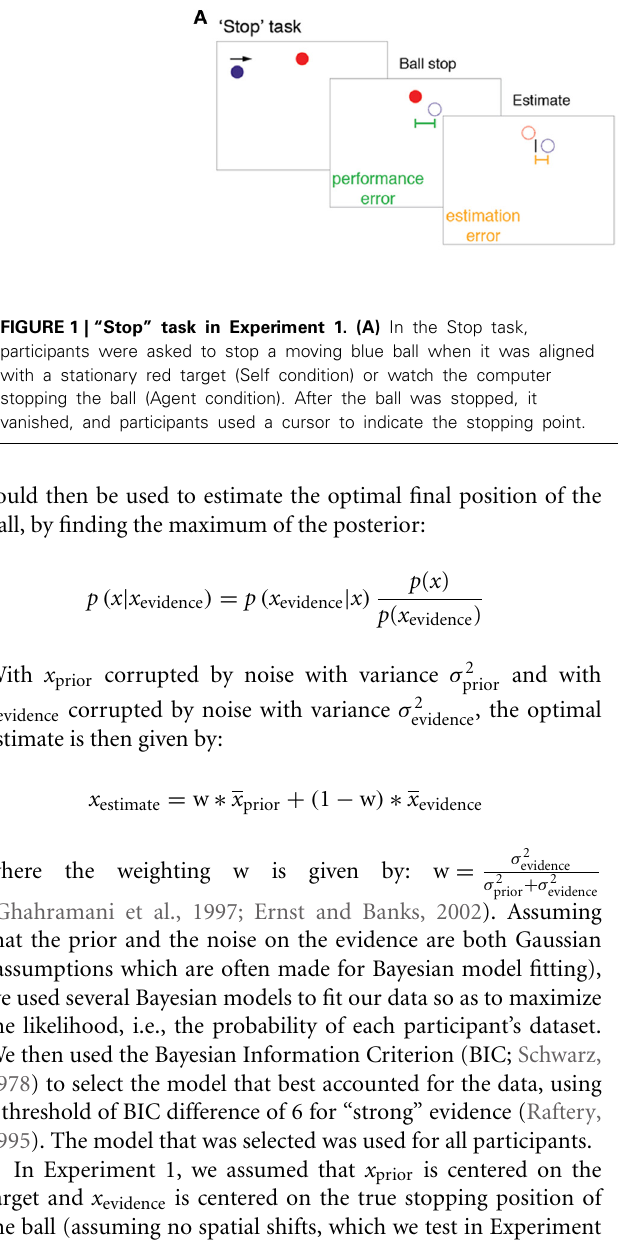
(B) Estimation errors (difference between estimated and true position) plotted against performance errors (difference between the true position and the target) for a typical participant in the Stop task with regression line (dashed) and SDs (error bars) for Self (cyan) and Agent (magenta, offset by 3 pixels for